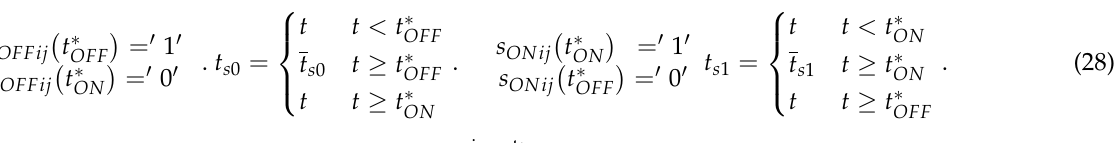
→ s ( a ) = ( 0,0,1,1 ) ; 2 2WD “hard” configuration